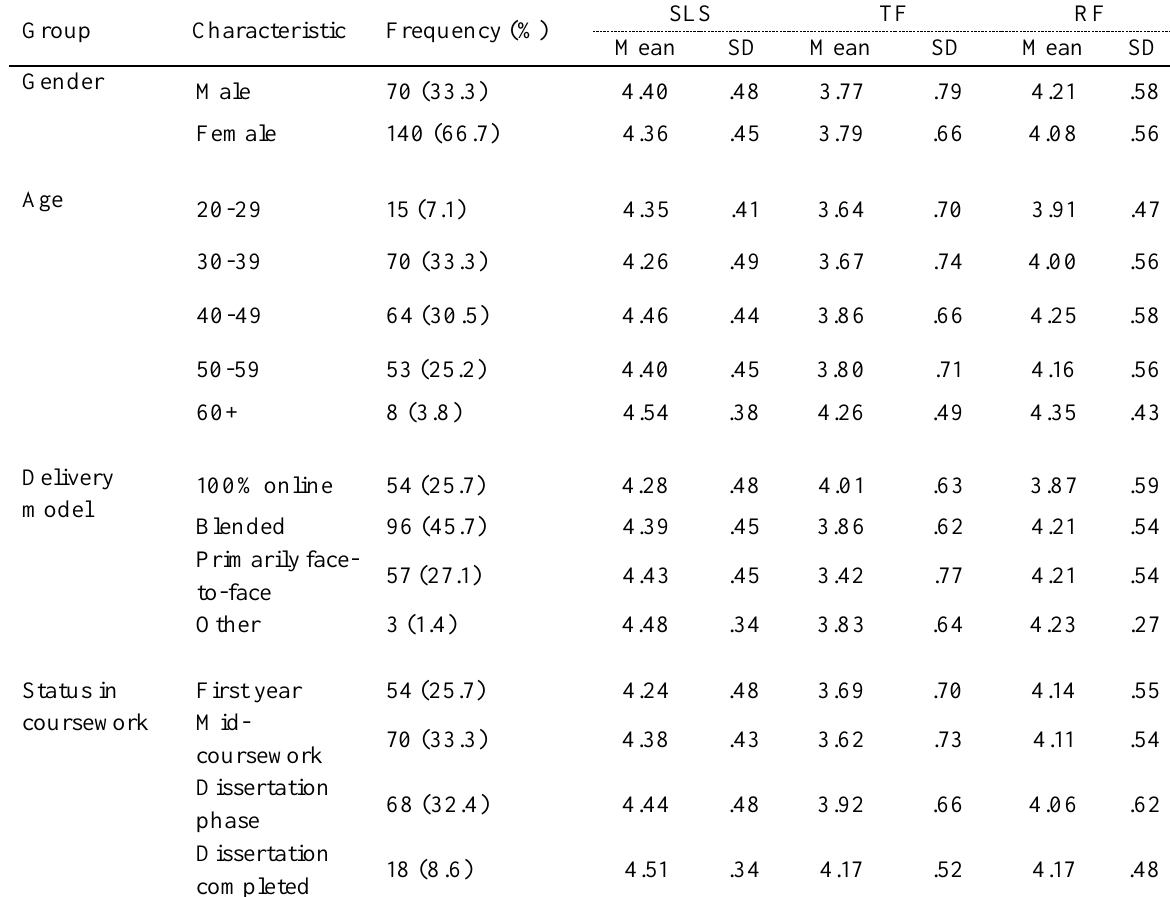
Means and Standard Deviations of the Three Variables (SLS, TF, and RF) Group